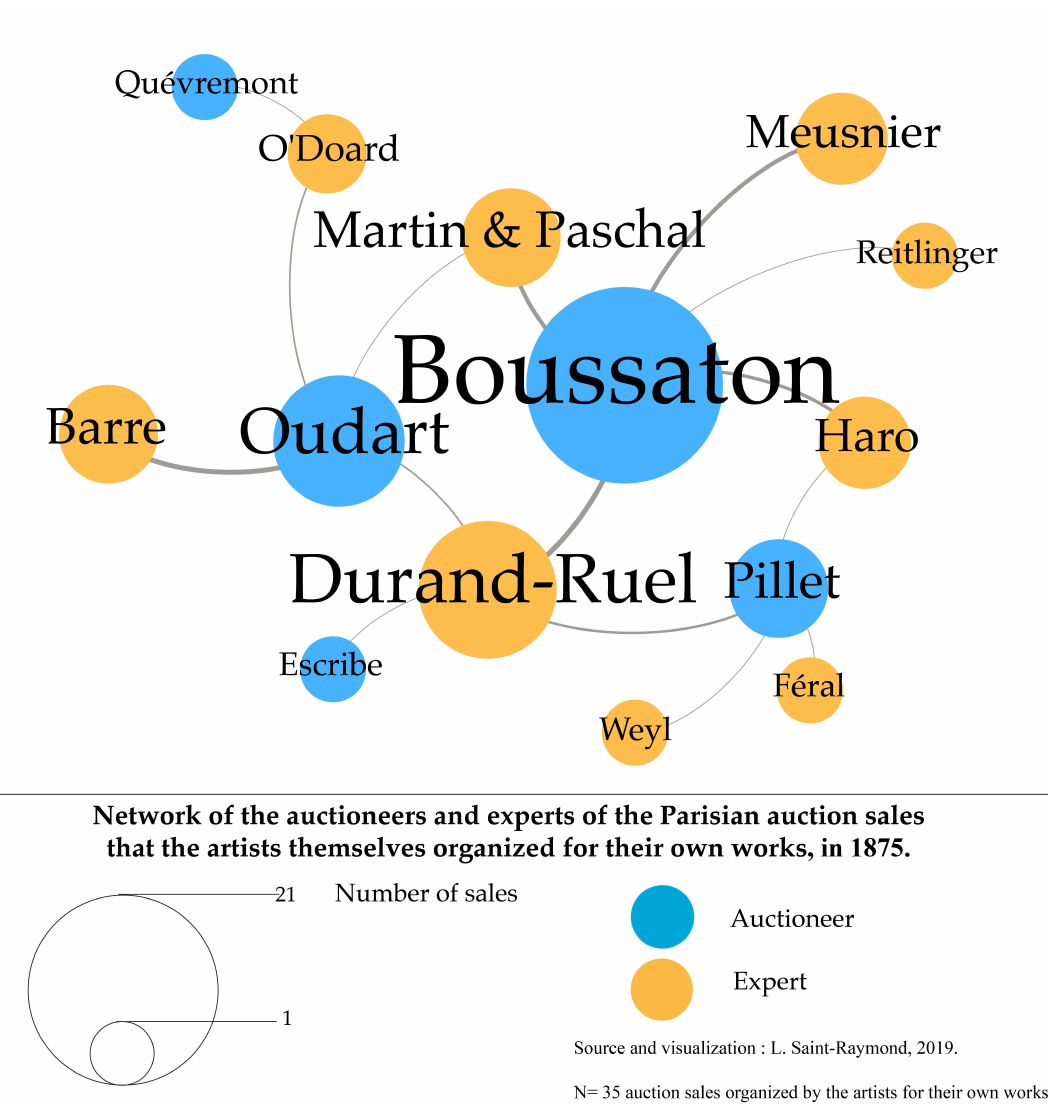
Figure 2. Network of the auctioneers and experts of the Parisian auction sales that the artists themselves organized for their own works, in